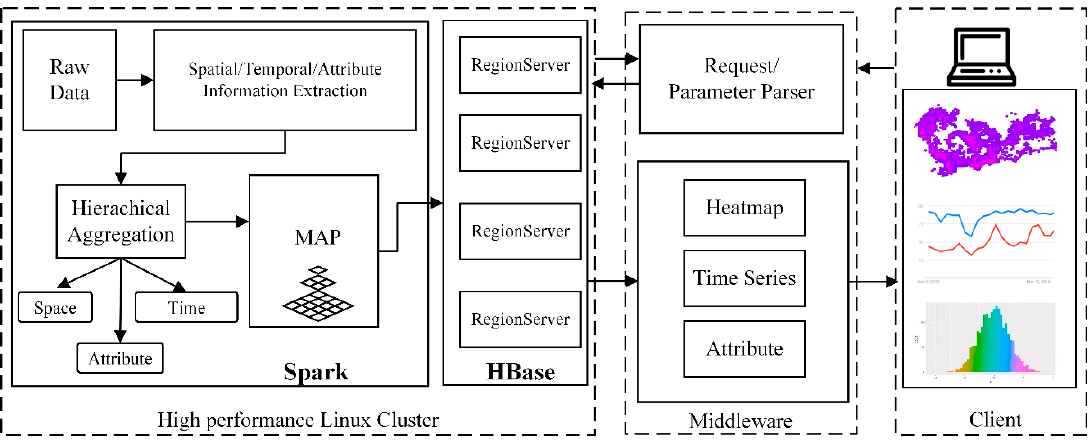
Figure 8. The system architecture of MAP-Vis.